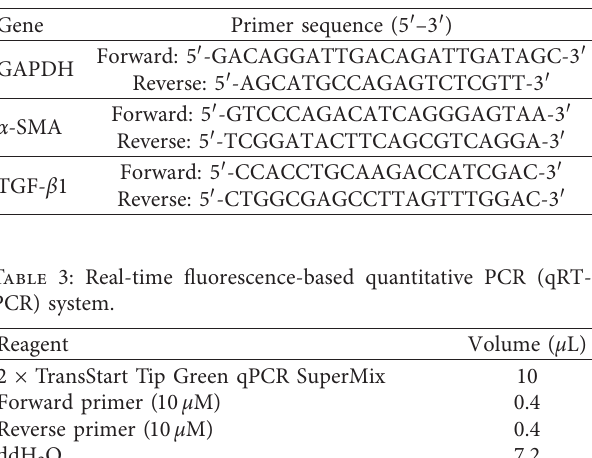
Table 2: Primer sequences for quantitative real-time PCR.